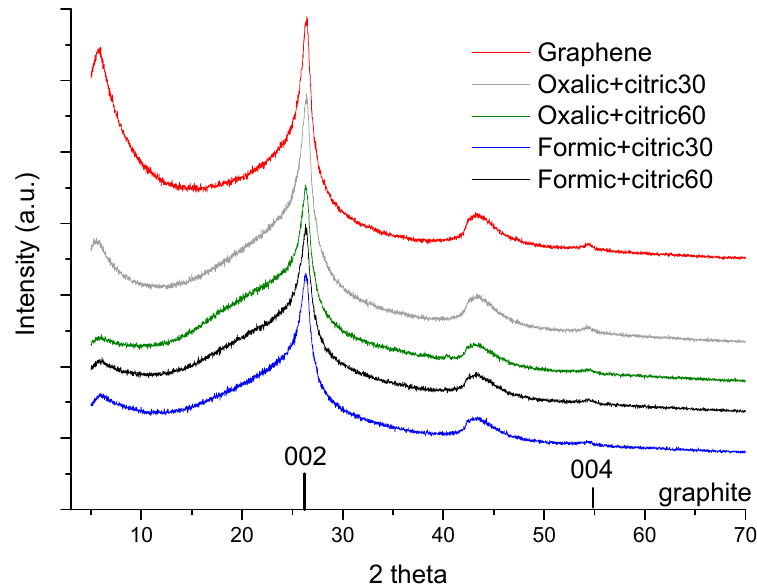
Figure 7. X-ray diffraction patterns of unmodified graphene and modified graphene.